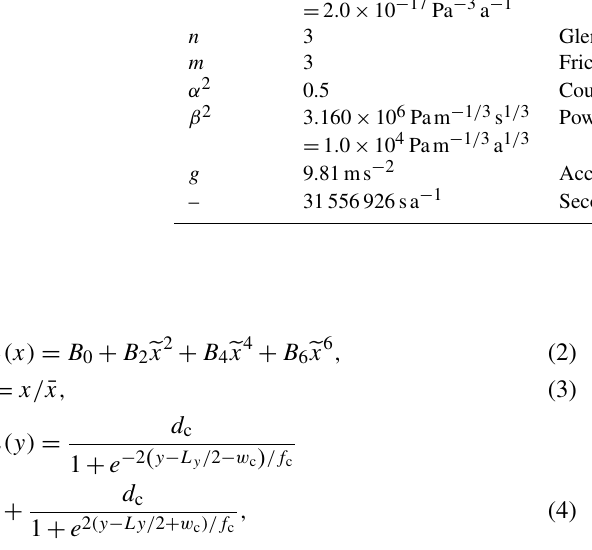
The location in x beyond which ice is